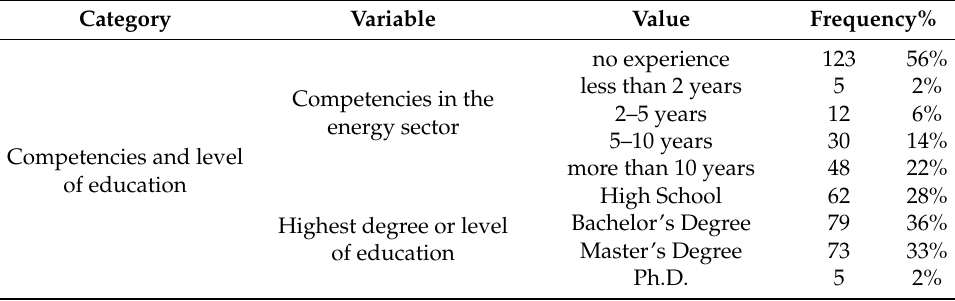
Table 4. Consumers’ competencies in the energy sector and their level of